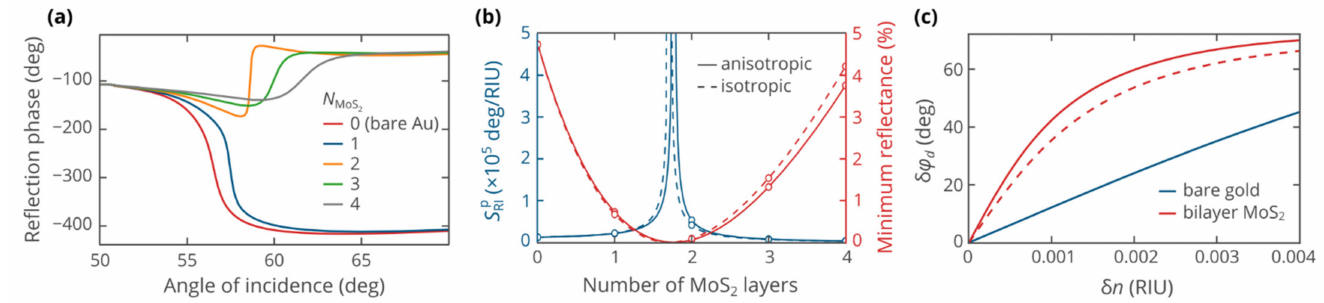
Figure 4. ( a ) The phase of the reflected p-polarized wave as a function of the angle of incidence, plotted at a variable number of atomic layers of MoS 2 . ( b ) The phase sensitivity and the minimum reflectance versus the thickness of MoS 2 cover, showing the singularity of sensitivity at a zero- reflection point. ( c ) Dependence of the biosensor signal on the refractive index change. The operating wavelength in all panels was set to 633